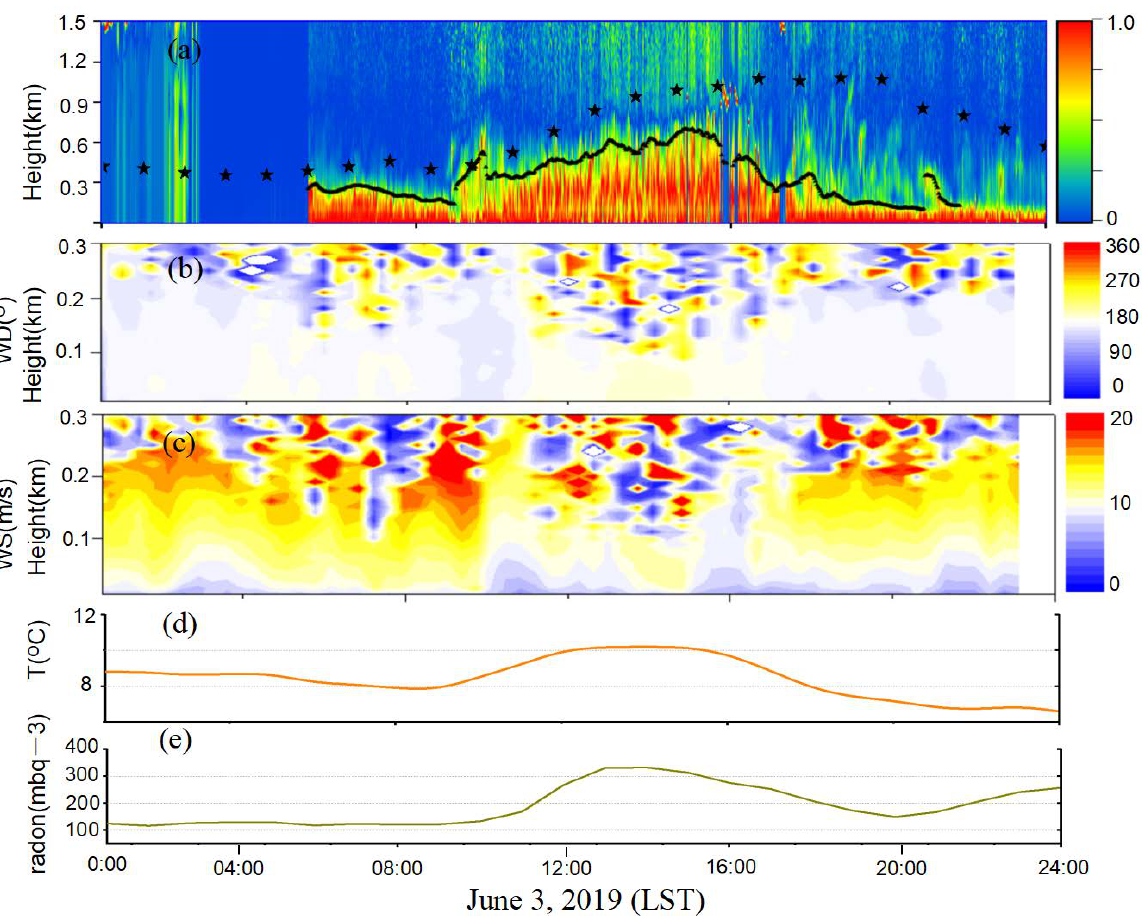
Figure 4. An example illustrating the retrieval of BLH using the ceilometer measurements obtained on 3 June 2019 over Cape Grim. ( a ) Time-height cross section of the range-squared corrected ceilometer signal intensity during the entire diurnal cycle. Black lines and black stars indicate the BLH estimations from the IED based on ceilometer and ERA5 reanalysis, respectively. Vertically aligned color bar (in linear scale) on the right indicates the intensity in arbitrary units. ( b ) Wind direction form sodar, ( c ) wind speed from sodar, ( d ) near-surface temperature, and ( e ) radon concentration.